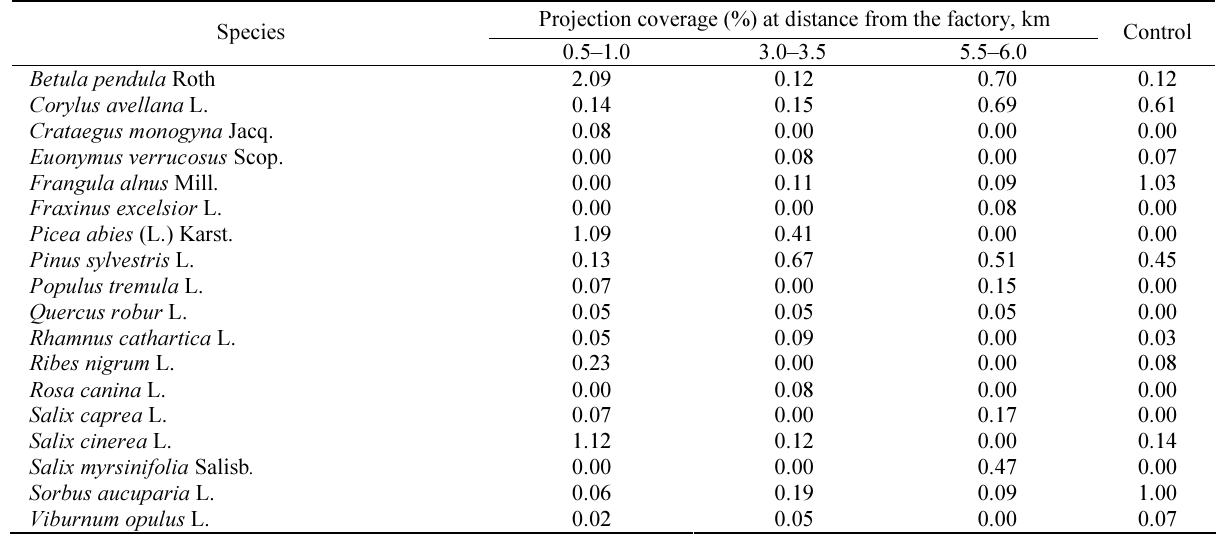
Table 4. Undergrowth (trees and shrubs) species and their projection coverage (%) at different distances from the pollution source and control forest stand (an average data from 36 vegetation sample quadrates at each distance and control) Projection coverage (%) at distance from the factory, km Species